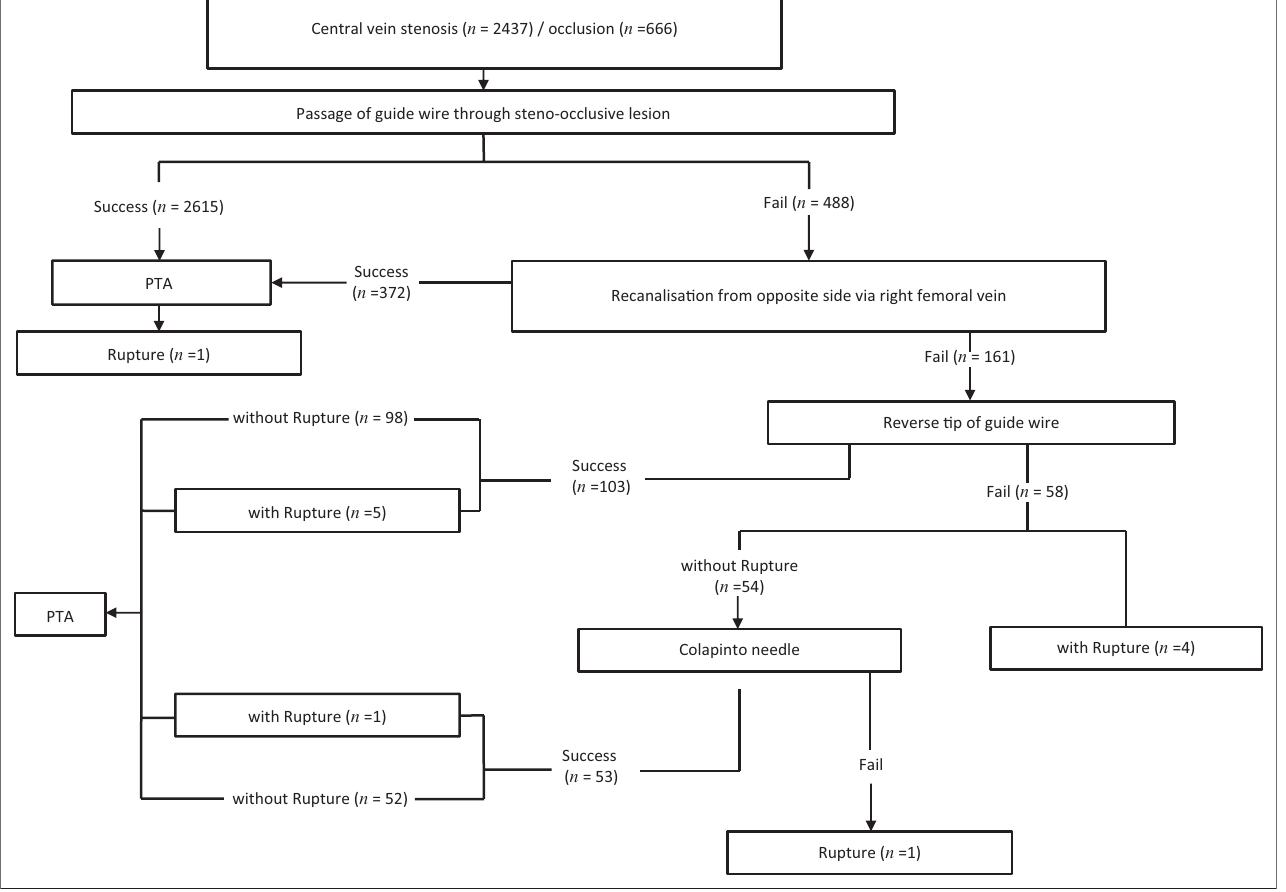
Central vein stenosis ( n = 2437) / occlusion ( n